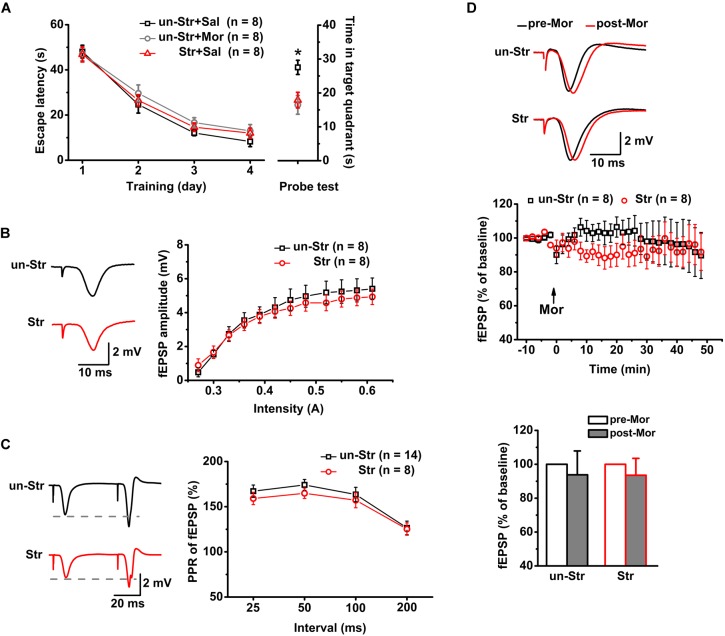
The effects of EP stress on memory retrieval and excitatory synaptic transmission in the CA1 region in wildtype mice. (A) Impairment of memory retrieval induced by EP stress or morphine injection before the probe test. All groups exhibited a similar escape latency during the MWM training days [group F(2, 21) = 1.12, p = 0.347; training day F(3, 63) = 121.07, p = 0.000; group × training day F(6, 63) = 0.37, p = 0.858; R-M ANOVA). Time spent in target quadrant of test trial F(2, 21) = 6.30, p = 0.007, one-way ANOVA; ∗p < 0.05 versus Sal + un-Str or Mor + un-Str group, Bonferroni post hoc test. (B) Stress does not alter the input/output curve of fEPSP amplitude. Treatment (stressed or unstressed) F(1, 14) = 0.45, p = 0.512; intensity F(11, 154) = 57.31, p = 0.000; treatment × intensity F(11, 154) = 1.15, p = 0.320; R-M ANOVA. (C) Stress does not change the PPR of fEPSPs at various IPIs. Treatment F(1, 20) = 0.50, p = 0.488; interval F(3, 60) = 29.13, p = 0.000; treatment × interval F(3, 60) = 0.87, p = 0.232; R-M ANOVA. (D) Morphine injection (15 mg/kg, i.p.) does not affect the fEPSP amplitude of unstressed and stressed mice. The bottom panel shows the histograms of fEPSP amplitude measurements (averaged from a 5 min period either before or after a 45 min morphine application) relative to baseline. Treatment (with or without morphine) F(1, 14) = 0.54, p = 0.475; group (with or without stress) F(1, 14) = 0.00, p = 0.989; treatment × group F(1, 14) = 0.00, p = 0.989; R-M ANOVA. un-Str, unstressed; Str, stressed; Sal, saline; Mor, morphine.